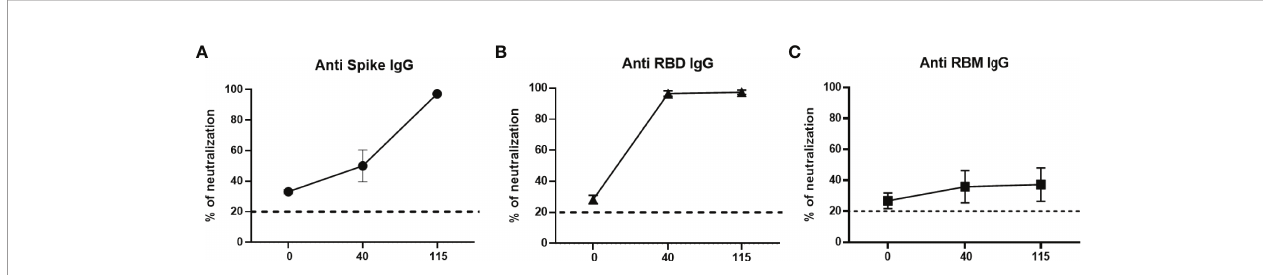
FIGURE 7 | Neutralizing ability of antibodies in mice. Neutralizing ability of anti-S (A) , anti-RBD (B) and anti-RBM (C) antibodies from immunized mice. Results are shown as the percentage of inhibition of speci fi c antibodies at different days (0, 40, and 115) post-immunization.